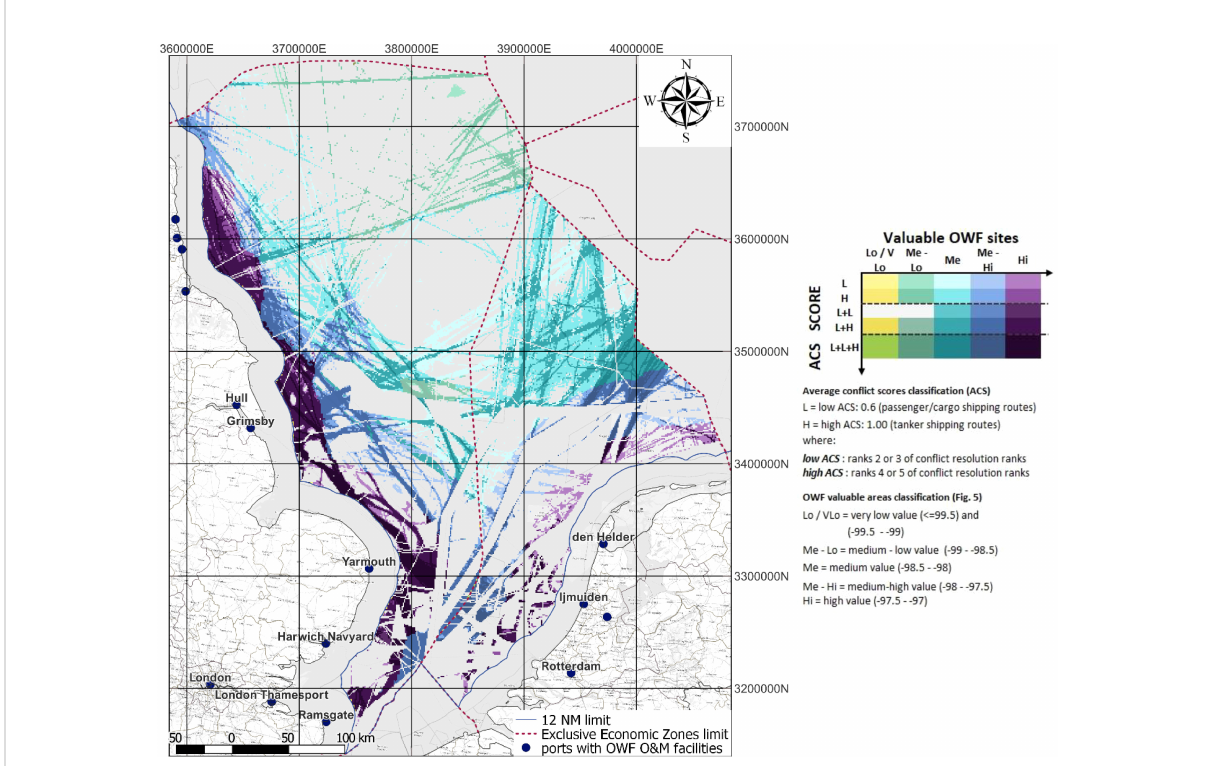
FIGURE 11 Average con fl ict resolution scores for the interaction between OWFs and shipping